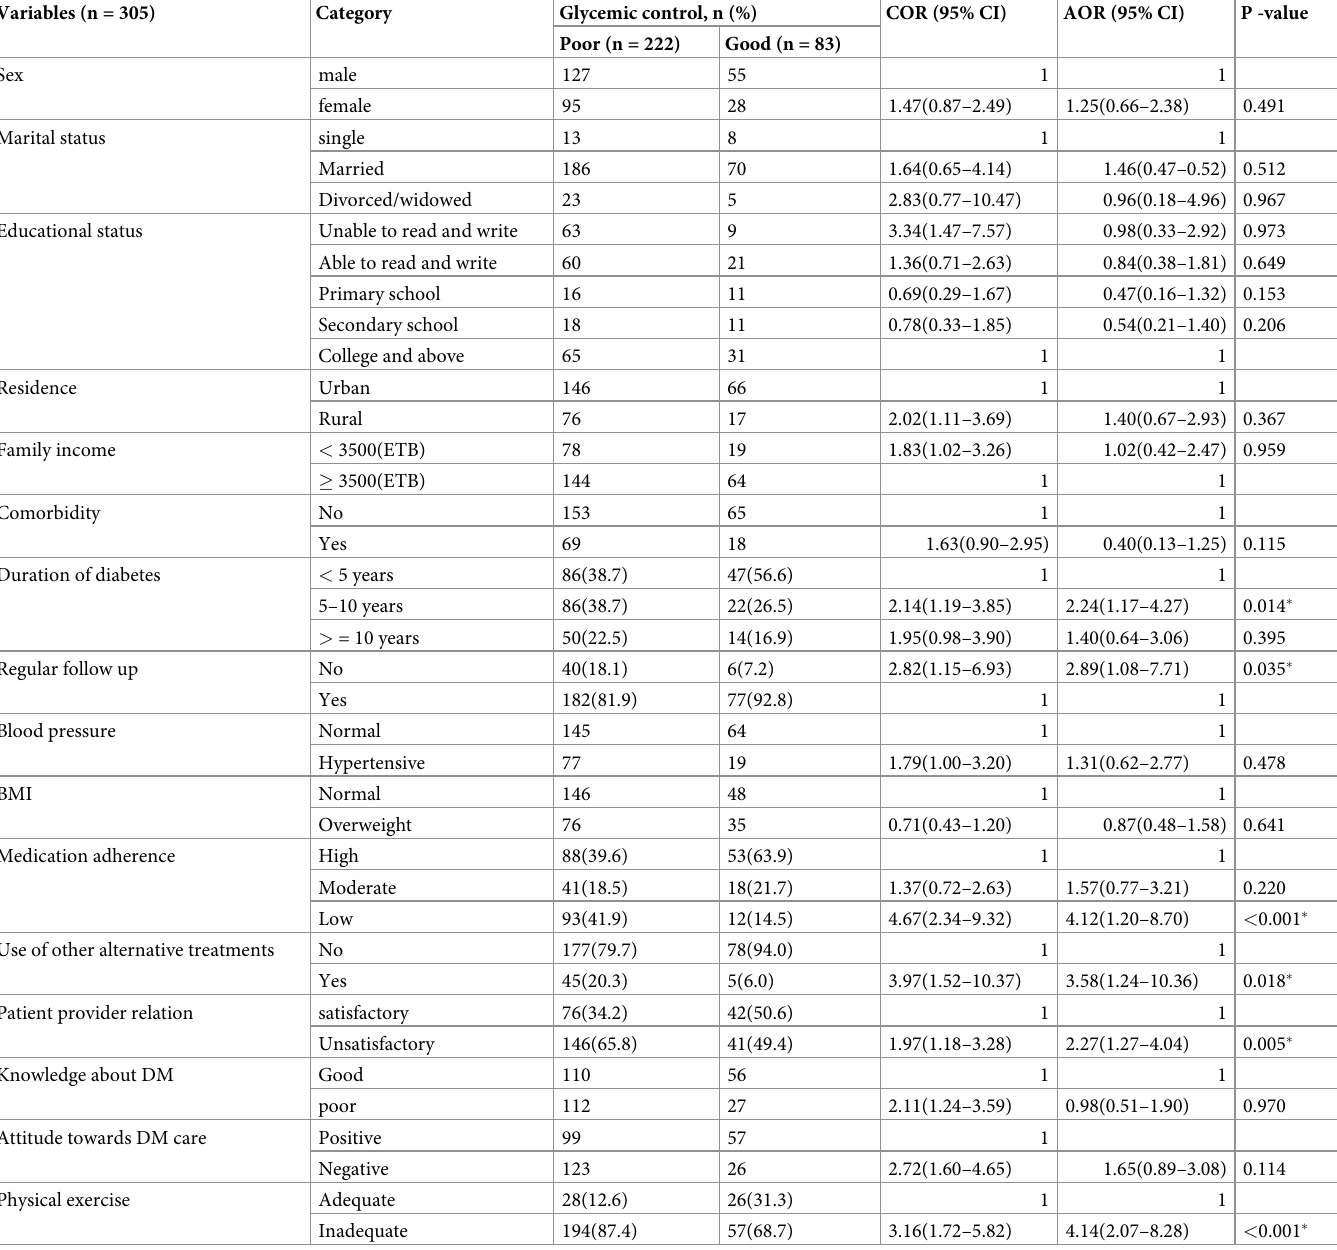
Table 3. Multivariable analysis of factors associated with poor glycemic control among T2 DM adult patients at Public hospital in Hadiya Zone, Southern Ethiopia, 2019. Variables (n =